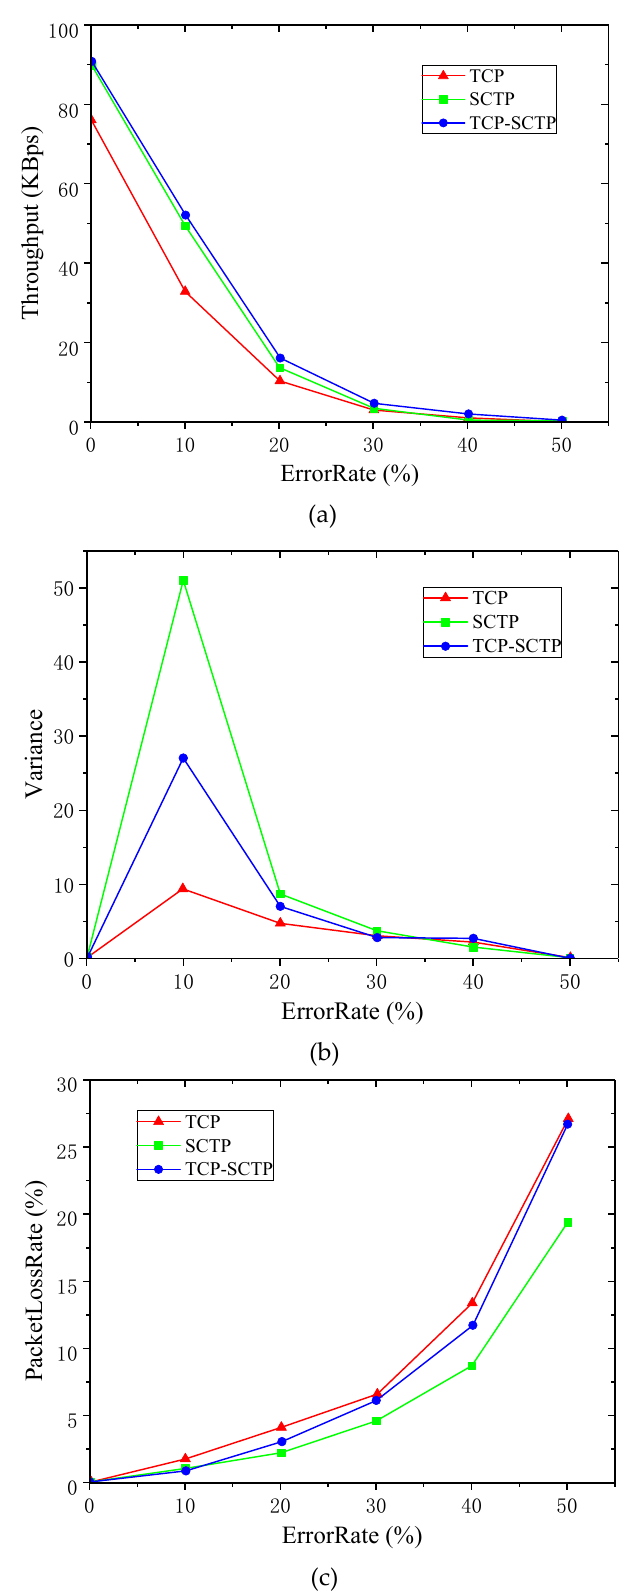
Figure 10. Comparison of three schemes performance. ( a ) Average throughput; ( b ) throughput variance; ( c ) packet loss rate.